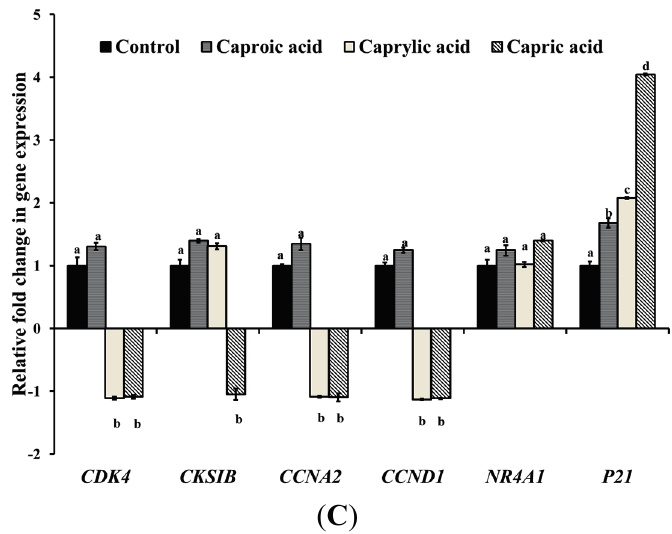
Figure 2. Effect of goat milk medium chain fatty acids on the expression of cell cycle progression- and apoptosis-associated genes in ( A ) human colorectal carcinoma cells; ( B ) human skin epidermoid carcinoma cells and ( C ) human mammary gland adenocarcinoma cells. Relative gene expression was assayed using the StepOne Plus Real-Time PCR System. The data were normalized to the endogenous control (16s RNA), and the level of candidate gene expression between treated and untreated samples was compared to study relative gene expression and the effect of capric, caproic and caprylic acids on candidate genes. Bars marked with letters (a, b, c, d) are significantly different at p < 0.05.